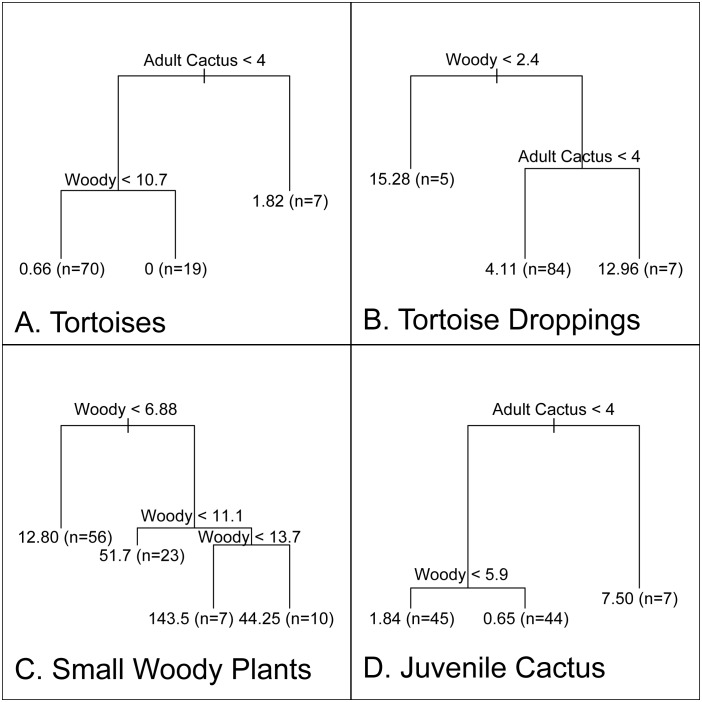
Relationships derived from binary classification trees between density of tortoises (A) and tortoise droppings (B) with thresholds of adult cactus density and large diameter woody plant density; between small diameter woody plants (C) with thresholds of large diameter woody plant density; and between density of juvenile cactus (D) with thresholds of large diameter woody plant density and adult cactus density.Density of tortoises, tortoise droppings, and cactus are expressed as number/hectare; woody plants as stems/100 m2.